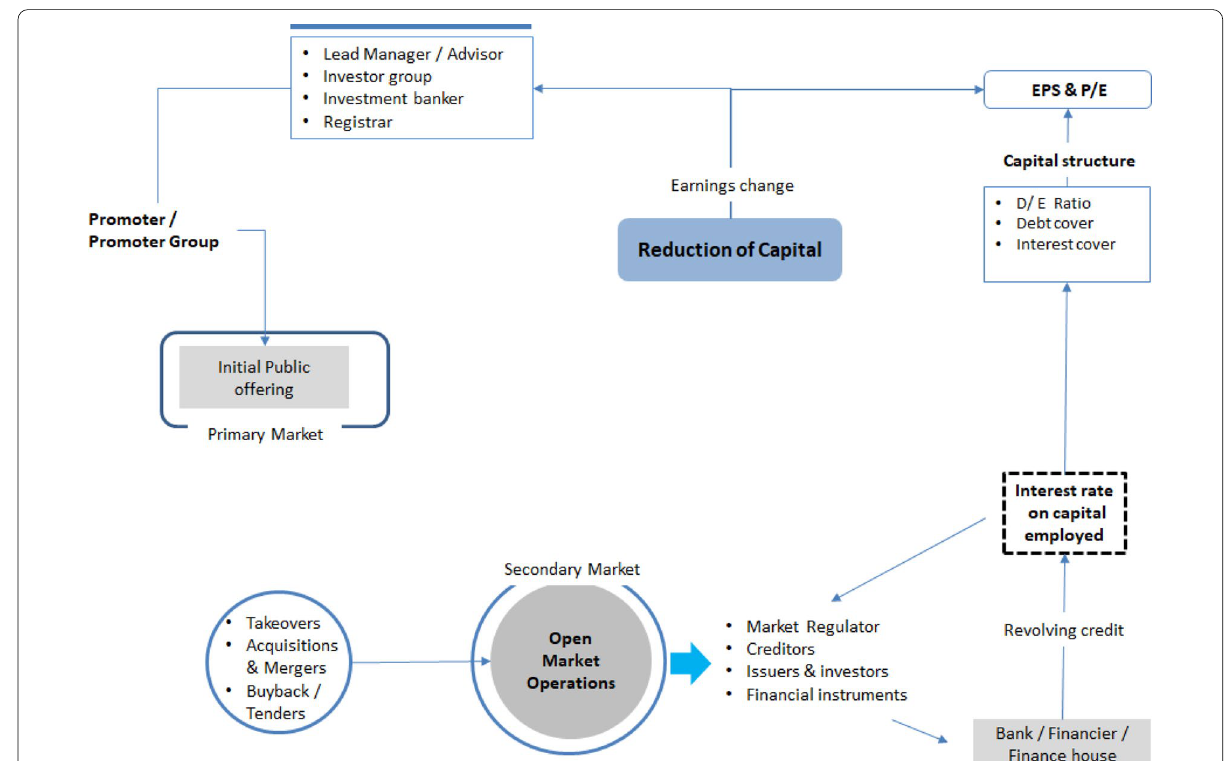
Fig. 7 Diagram showing relationship among capital market entities and capital structure ratios on the earnings yield and earnings per